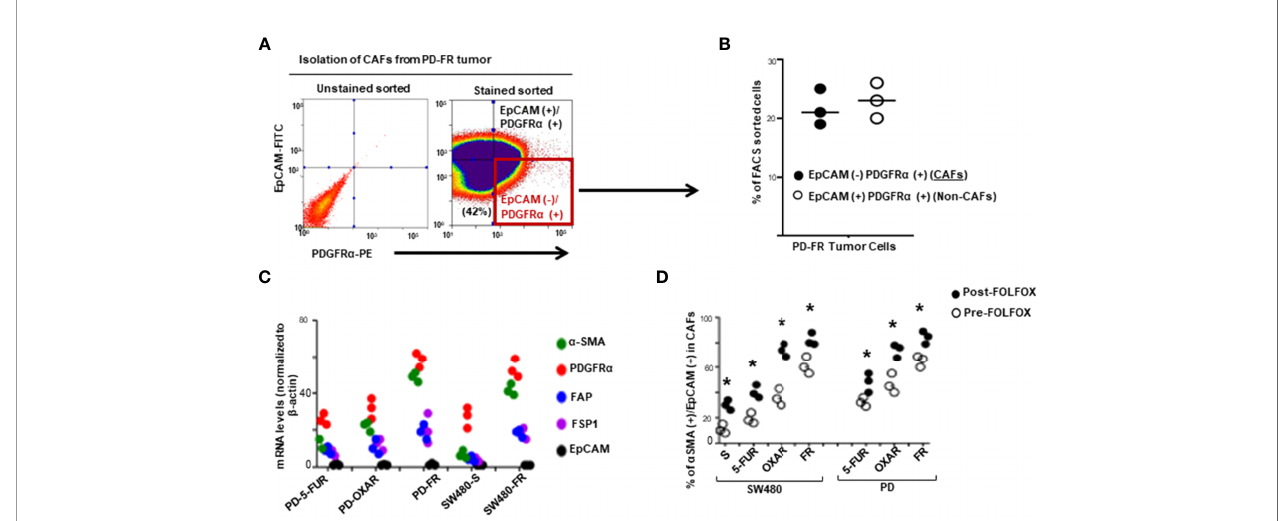
FIGURE 1 | Cancer associated fi broblasts (CAFs) account for tumor resistance to FOLFOX. (A) , Single cell suspensions isolated from a dissociated colorectal tumor (PD-FR) from a FOLFOX resistant (FR) patient were sorted by FACS using PDGFR- a -PE and EpCAM-FITC. CAFs were analyzed by FACS using: (i) the epithelial marker EpCAM-FITC; and (ii) the functional fi broblast cell immunophenotype by PDGFR- a -PE. (B) , Percentages of EpCAM [-]/PDGFR- a [+] (CAFs) and of EpCAM [+] /PDGFR- a [+]) (Non-CAFs) in total unsorted cell populations were quanti fi ed. (C) , The integrities of CAFs (EpCAM [-]/PDGFR- a [+]) from the dissociated patient colorectal specimens (PD-5FUR, PD-OXAR, PD-FR), and from the sensitive and FOLFOX resistant SW480/subcutaneous (SQ) tumor tissues were con fi rmed by QPCR analyses for CAF- associated markers FSP1, FAP and PDGFR- a , and for epithelial cell marker EpCAM (negative control), and for ☐ SMA. (D) , CAFs from the PD- 5FUR, PD-OXAR, PD-FR, SW480-S and SW489-FR (SQ) tumors were cultured in DMEM with 10% BSA and were further sorted by FACS using a SMA-FITC and PDGFR- a -PE antibodies. The percentages of the sorted a SMA (+)/PDGFR- a [+] cells in total EpCAM [-]/PDGFR- a [+] cells were quanti fi ed. Data are presented as Mean ± SD from six independent replicates in three independent experiments. (D) , *, P < 0.05 was considered signi fi cant, percent CAFs with post-FOLFOX treatment compared with pre-FOLFOX-treated cells after normalization to CAFs of serum starved untreated SW480 controls. Student ’ s t-test was used to assess the signi fi cance.